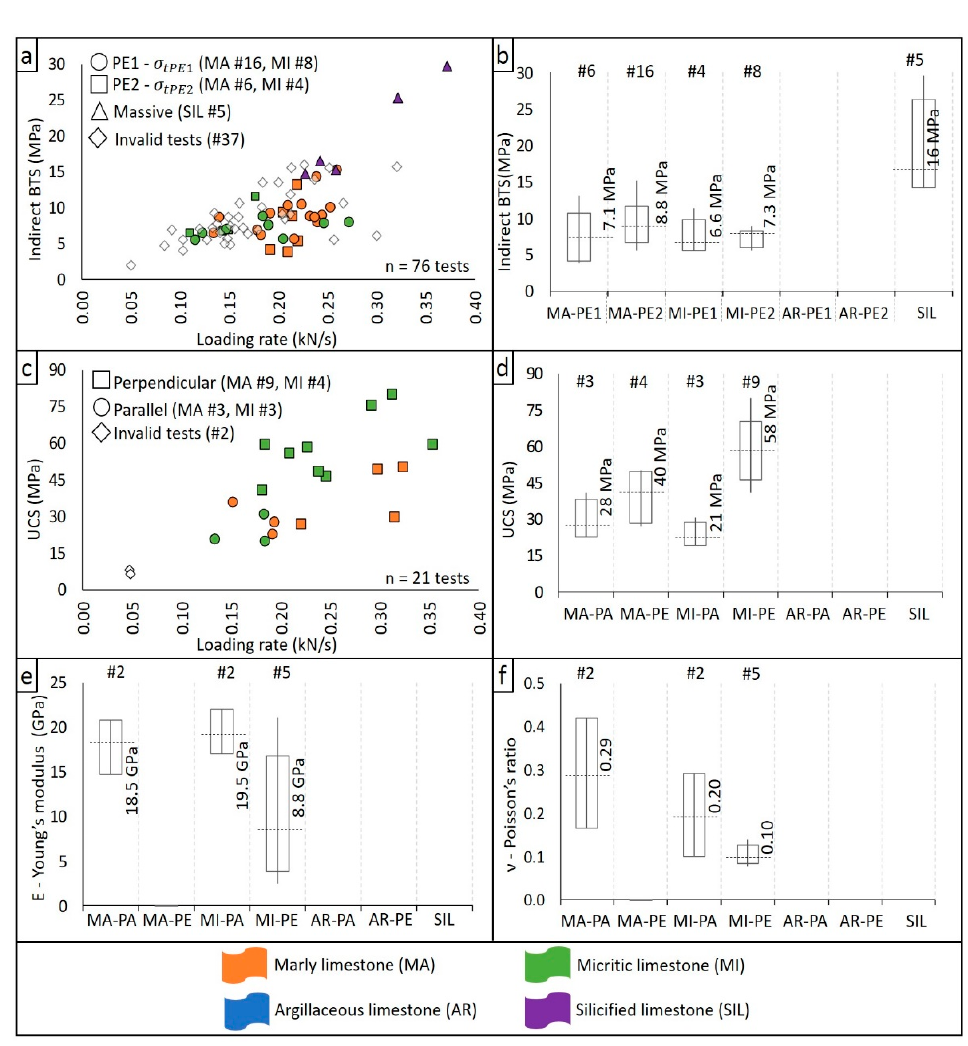
Figure 6. Mechanical results for BTS and UCS tests, with the number of samples (#) indicated in individual graphs. Middle bars and values in box plots show the median value. ( a ) loading rate of BTS tests and strength; ( b ) indirect tensile strength results; ( c ) loading rate of UCS tests and strength; ( d ) UCS results; ( e ) Young’s modulus; ( f ) Poisson’s ratio. PA: parallel; PE: perpendicular. # stands for number of samples.